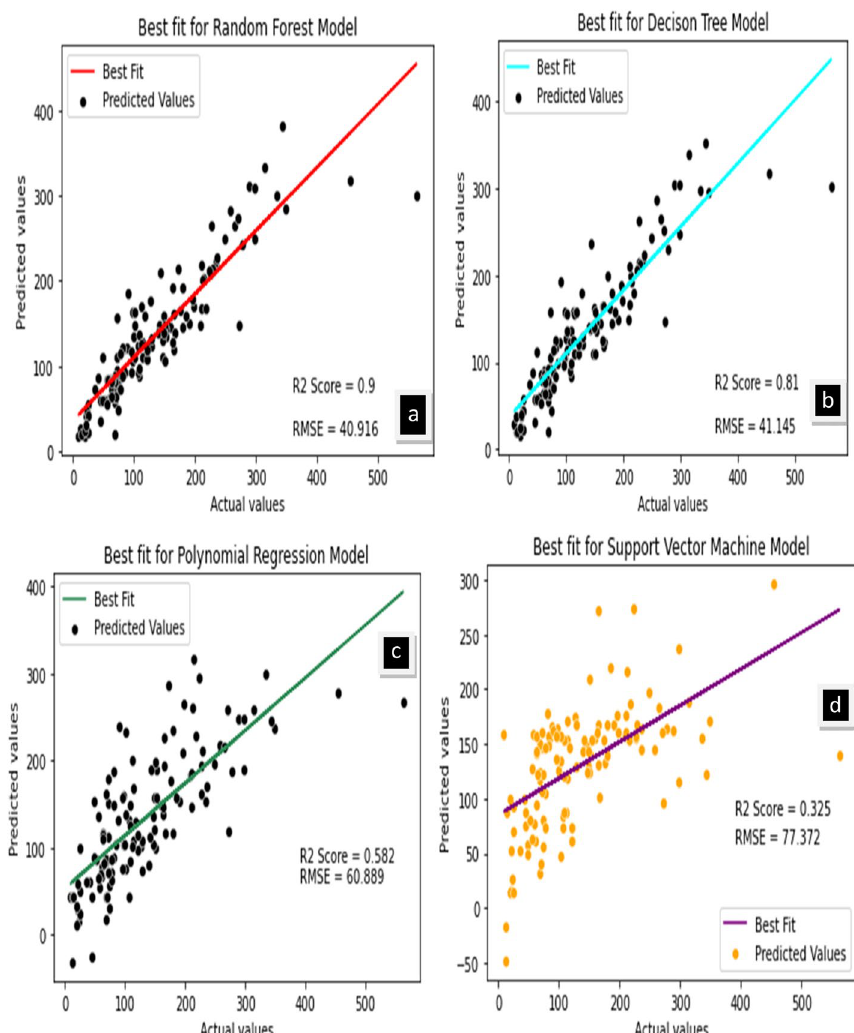
Fig. 3 a Comparisons between experimental based output (actual) versus random forest (RF) model predictions, b comparisons between experimental-based output (actual) versus decision tree (DT) model, c polynomial regression model (PM), and d support vector machine